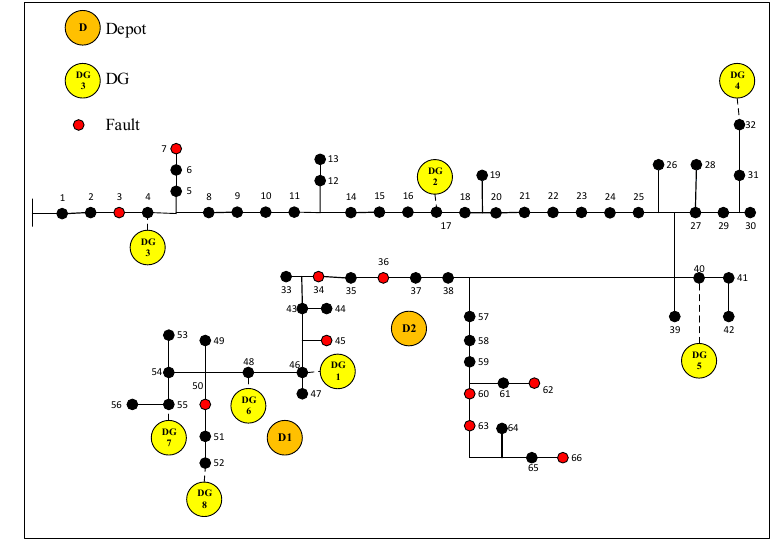
Figure 9. Iranian 66 bus power distribution feeder. Table 6. Needed resources and time for